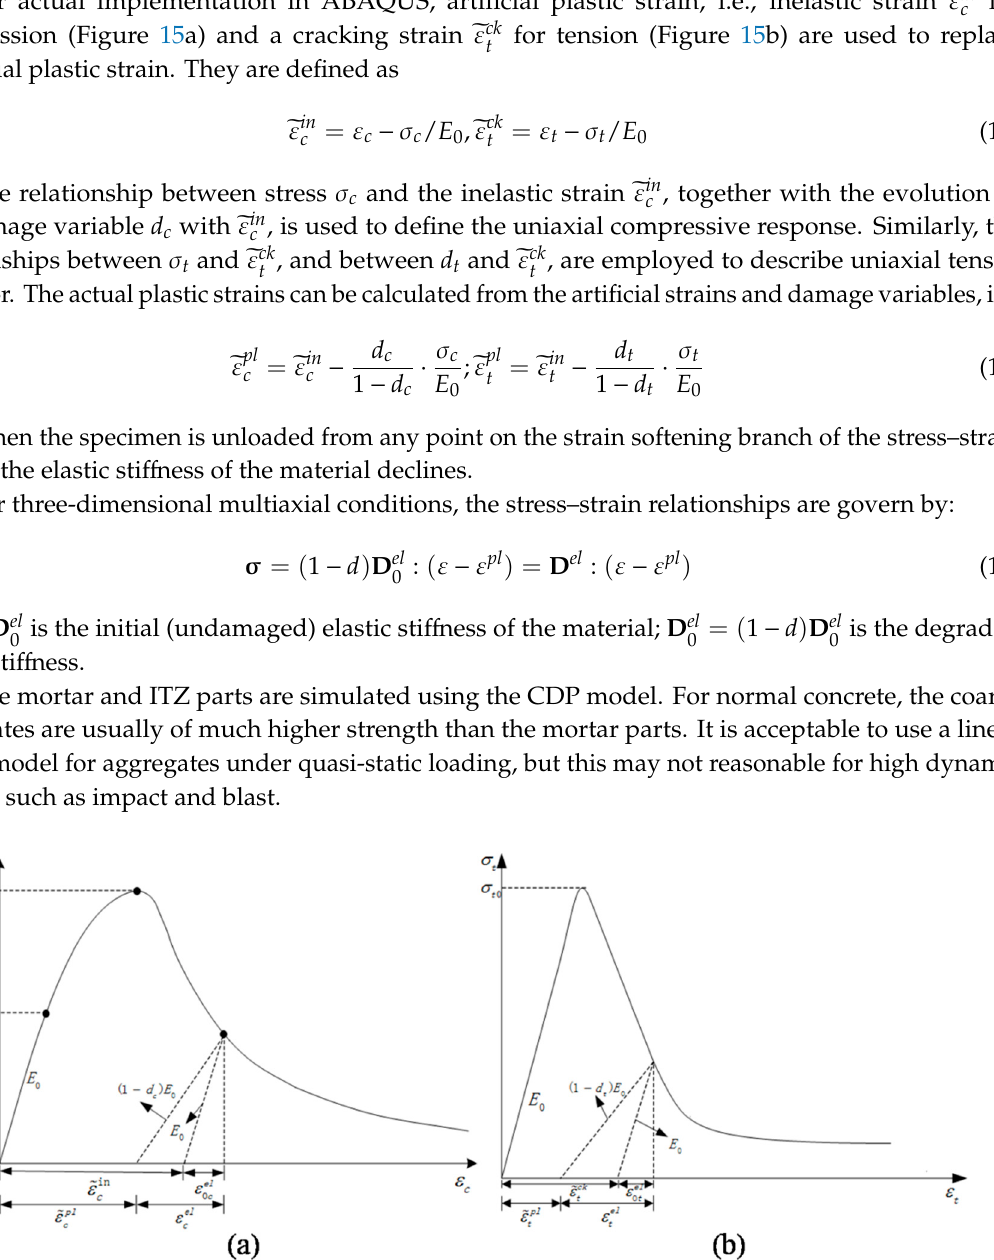
352 Figure 16. 3D mesoscale model of three different size distributions.